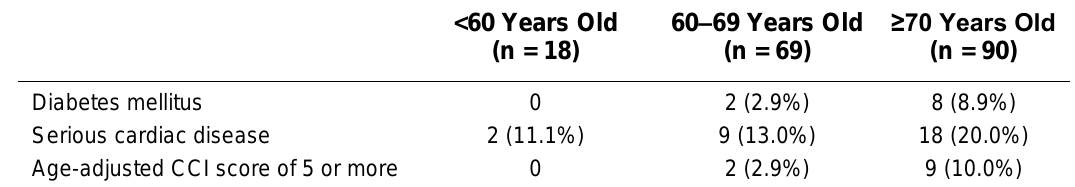
Comorbidity Stratified by